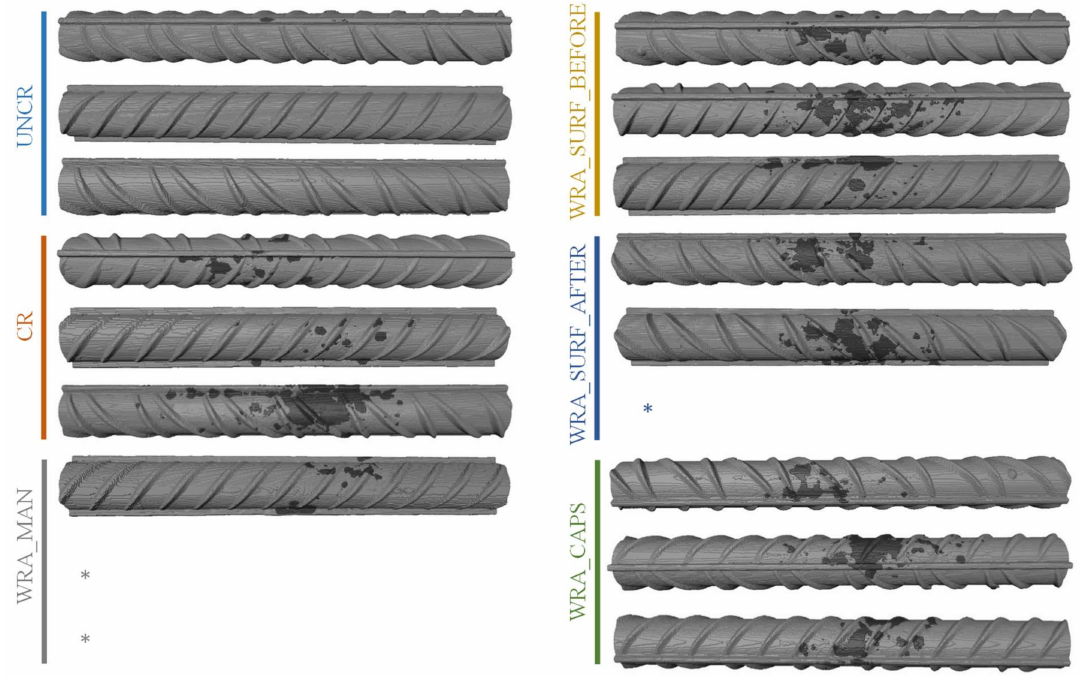
Figure 13. 3D render of the middle part of the anode showing the corroded zones at one side of the reinforcement bar (dark area) (* indicates that the X-ray µ CT analysis was not successful for this rebar as some bars bended while taking them out of the concrete